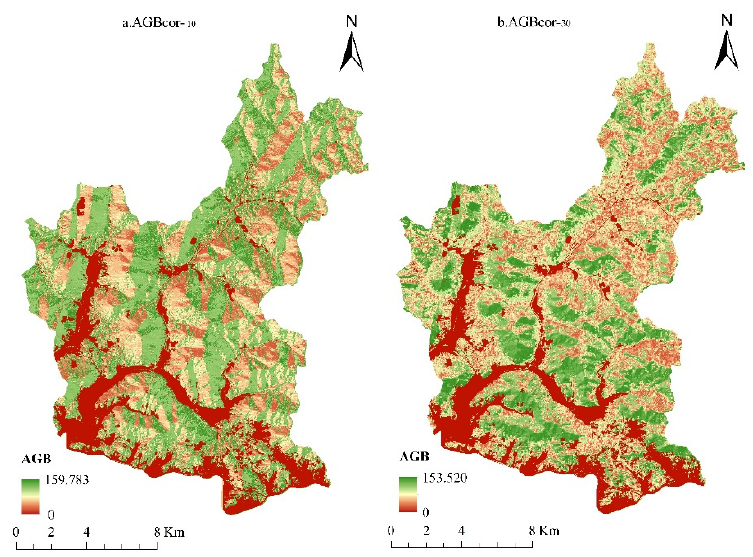
Figure 9. The scale error-corrected AGB distribution at 10 m and 30 m spatial resolution. ( a ) Corrected AGB at 10 m; ( b ) corrected AGB at 30 m. (Unit was t/ha).